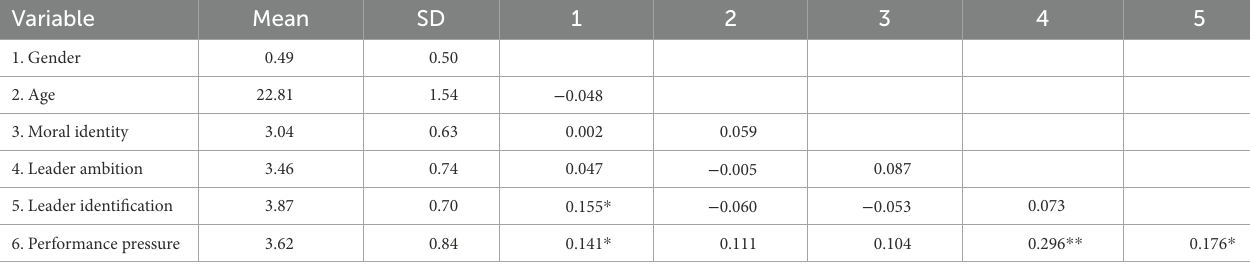
TABLE 1 Study 1 - means, standard deviation, and correlation among study variables.